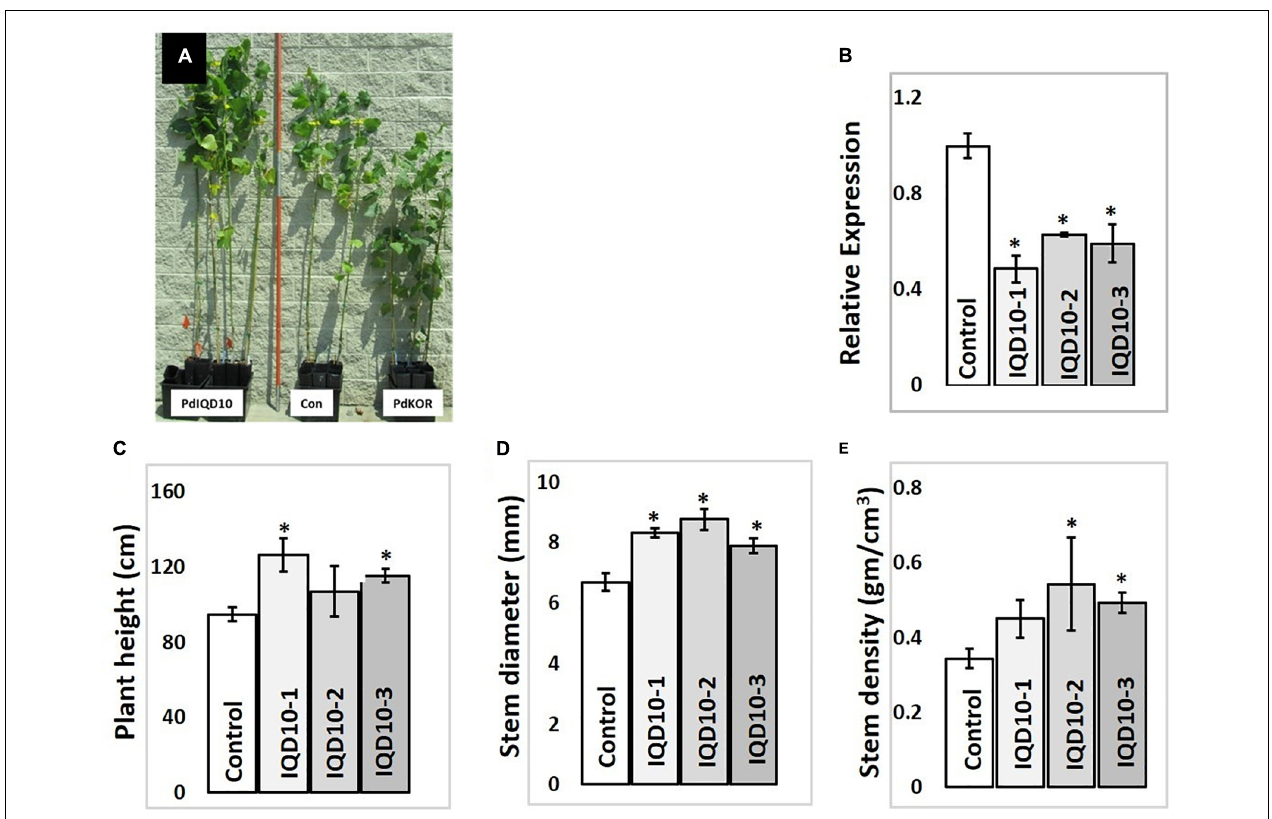
FIGURE 7 | Growth characterization of PdIQD10 RNAi lines (A) 6-month -old greenhouse grown transgenic plants representing IQD RNAi ( PdIQD10-1 ), empty vector control and a comparator reduced biomass line PdKOR RNAi (Kalluri et al., 2016). (B) qRTPCR validation of RNAi-mediated downregulation of PdIQD10 gene in three independent RNAi lines. (C) Measurements of average plant height, (D) stem diameter and (E) stem density of PdIQD10 RNAi lines in comparison with that of vector control lines. Data represent means ± SE ( n = 3–5). ∗ Indicates statistically significant, p ≤ 0.05 based on Student’s t